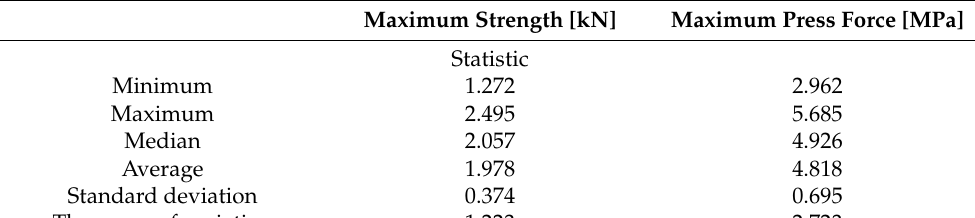
Figure 34. Average values obtained during compressive strength tests after 28 days for water − mix ratio = 0.6, max. pressure. For compressive strength tests, all grout mixtures had lower values than the zero sample. The lowest result was obtained for an additive concentration of 50%, whose value was about 74% lower. For remaining samples, the reduction varied between 5% and 63%. Table 21. Flexural strength tests for basalt dust B for all samples for water − mix ratio = 0.7 after 28 days.